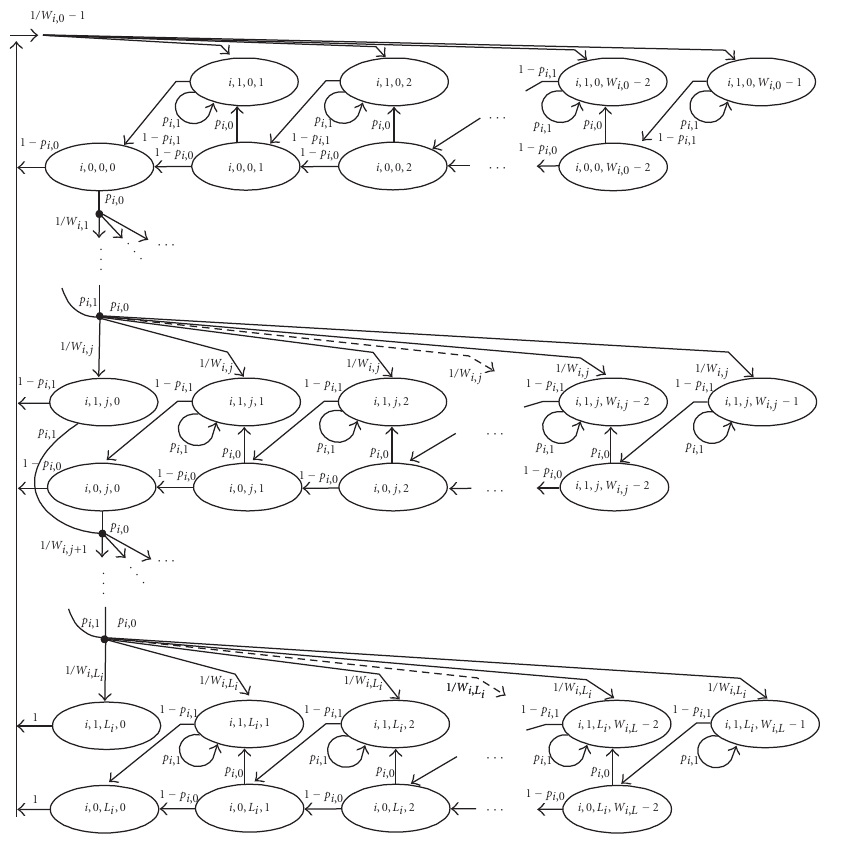
Figure 1: Analytical Markov chain for each access category AC[ i